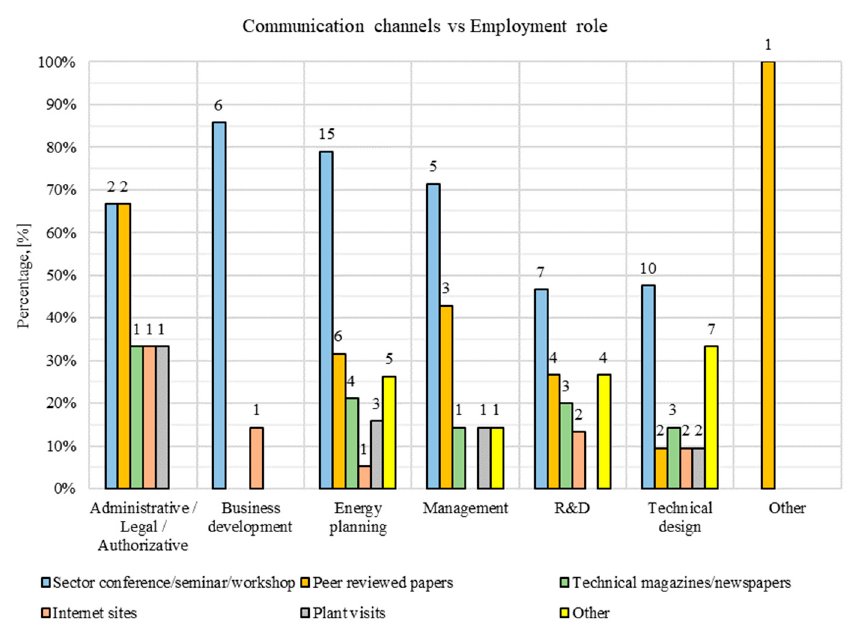
Figure 12. Communication channels as a function of the role within the organization.